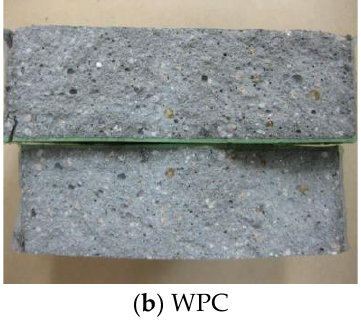
Figure 8. Impacting spots of steel ball.